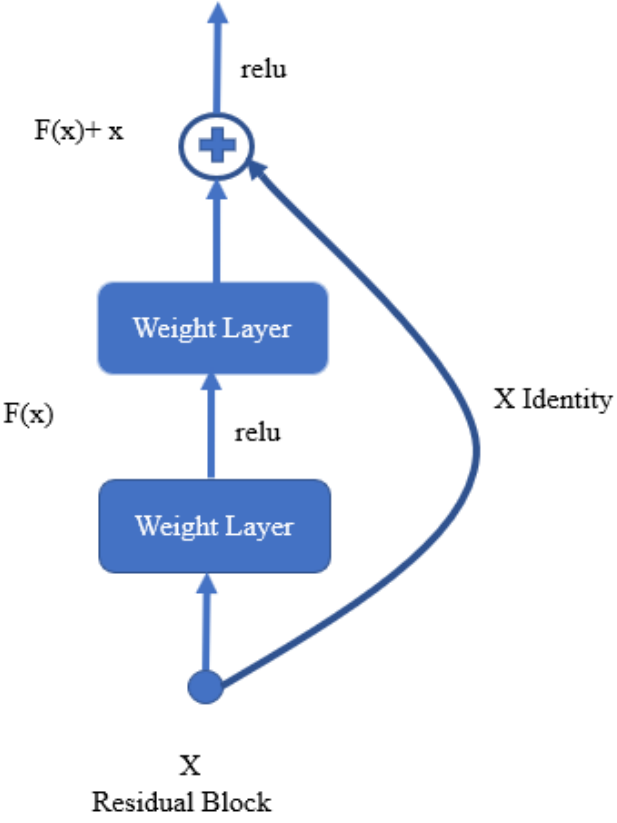
Figure 5. Residual